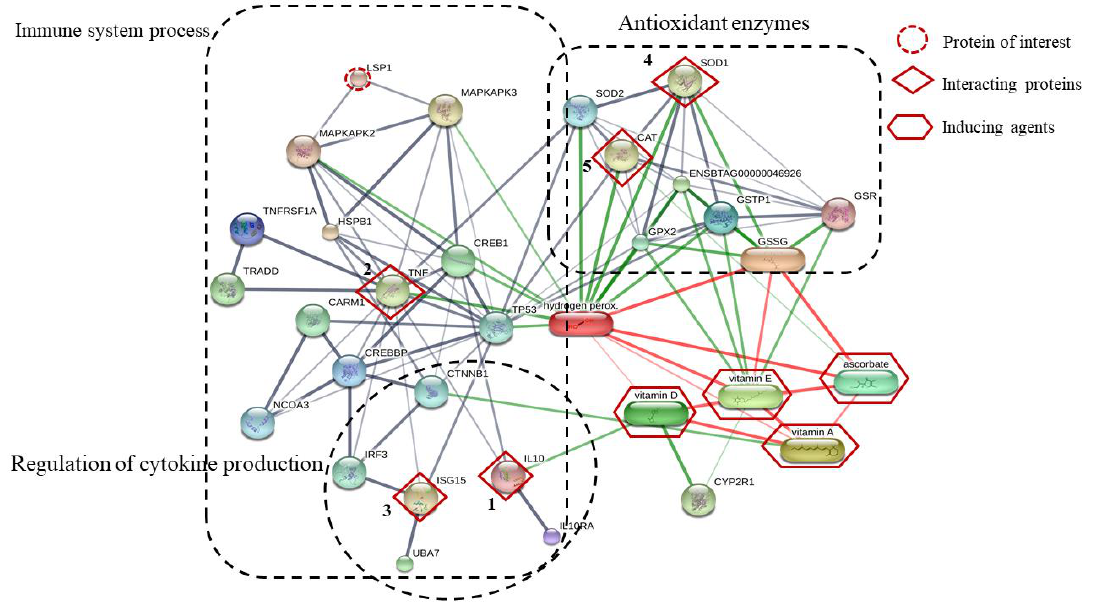
Figure 5. The network of the one identified protein of interest and five interacting proteins predicted by STITCH database based on the following analysis parameters: species ( Bos tarus ); medium confidence score (0.4); active prediction method (no more than 10 interactions). The one protein of interest is lymphocyte-specific protein 1 (LSP1); the five interacting proteins include (1) interleukin 10 (IL-10), (2) tumor necrosis factor-alpha (TNF- α), (3) interferon-stimulated gene 15 (ISG15), (4) superoxide dismutase 1 (Cu-Zn) (SOD1), and (5) catalase (CAT), as well as the inducing agent (vitamin A, vitamin D, vitamin E, and ascorbate). Abbreviation: Glutathione dimer formed by a disulfide bone (GSSG), glutathione reductase (GSR), glutathione S-tranferase P (GSTP1), glutathione peroxidase 2 (GPX2), glutathione peroxidase (ENSBTAG00000046926), superoxide dimutase 2 (Mn) (SOD2), hydrogen peroxide (Hydrogen perox), vitamin D25 – hydorxylase (CYP2R1), cellular tumor antigen p53 (TP53), interleukin-10 receptor subunit alpha precursor (IL10RA), ubiquitin-like modifier- activating enzyme 7 (UBA7), catenin beta-1 (CTNNB1), interferon regulatory factor 3 (IRF3), CREB- binding protein (CREBBP), uncharacterized protein (NCOA3), uncharacterized protein (CARM1), tumor necrosis factor receptor type 1-associated DEATH domain protein (TRADD), tumor necrosis factor receptor superfamily (TNFRSF1A), cyclic AMP-responsive element-binding protein 1 (CREB1), heat shock protein beta 1 (HSPB1), MAP kinase-activated protein kinase 3 (MAPKAPK3), MAP kinase-activated protein kinase2 (MAPKAPK2).